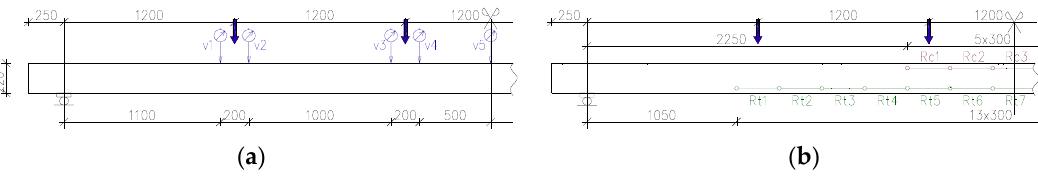
Figure 5. Location of LVDT gauges: ( a ) vertical displacement; and ( b) horizontal concrete strain.